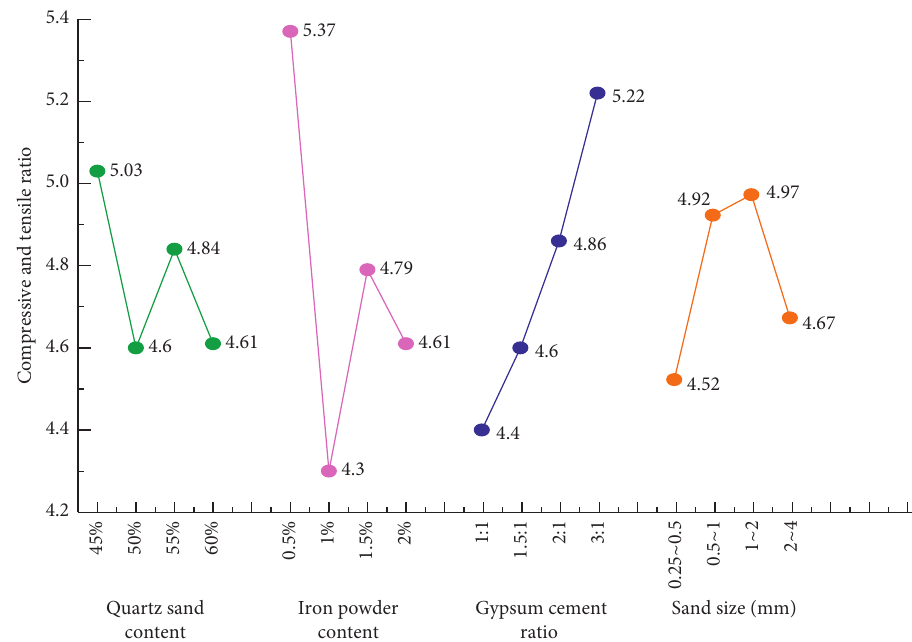
Figure 10: Influence of various factors on the compressive and tensile strengths of similar materials covered by the study. Table 7: Analysis of the difference in elastic modulus of each factor covered by the study. Factor level